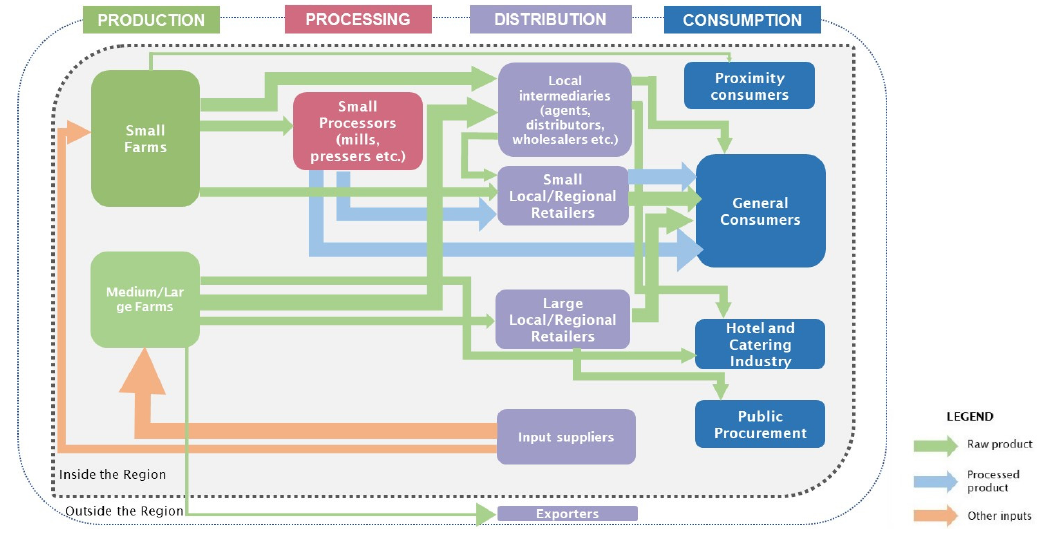
Figure 3. Regional food system for banana .